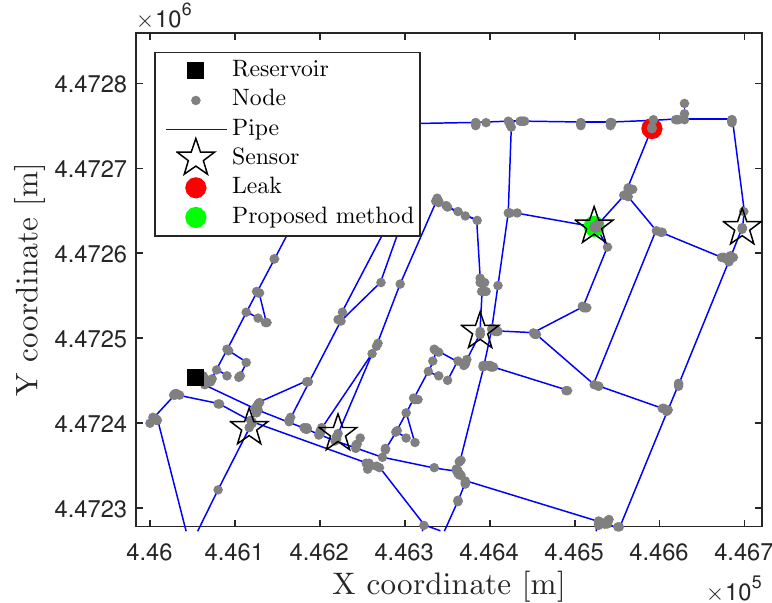
Figure 13. Madrid DMA topological network and their sensor